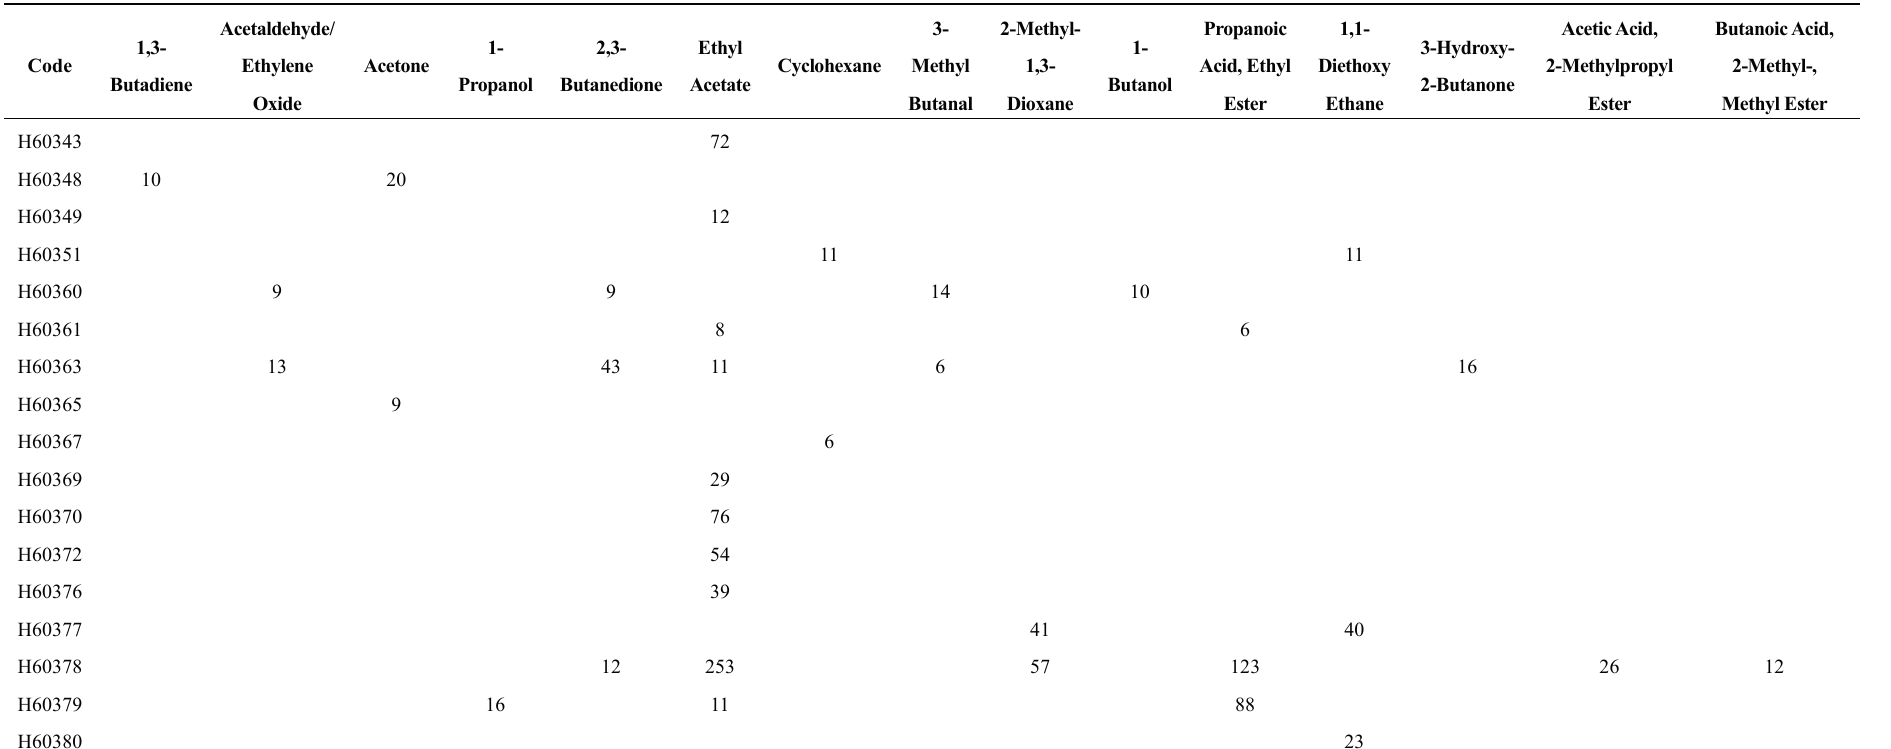
Table 4. Solvents (in µg/g) in bottles of e-liquids, 2013 *